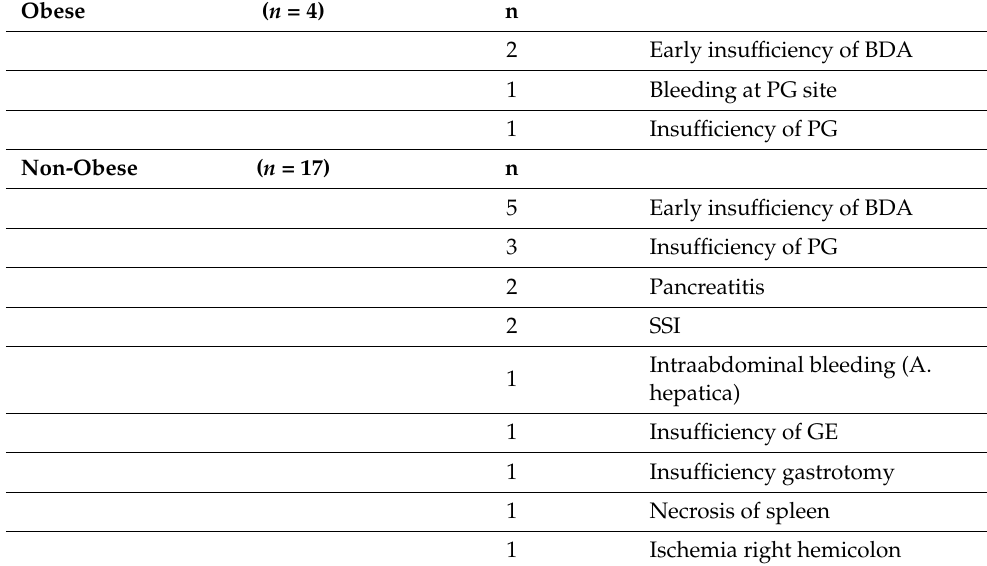
Table 3. Reasons for reoperation.